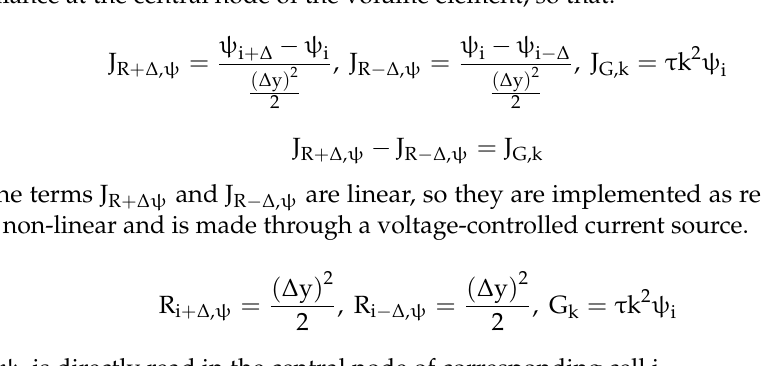
secondary circuit. Rectangular domains. ψ